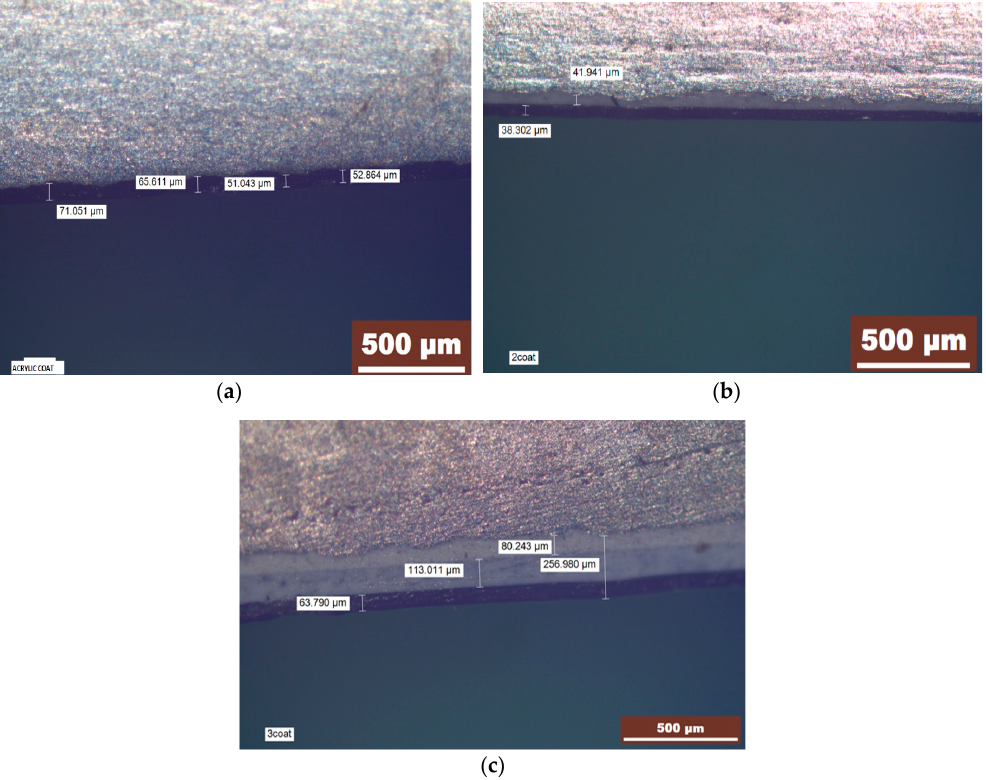
Figure 6. Microstructure images of the coating thickness: ( a ) Acrylic paint ED coat; ( b ) 2-coat polyester without primer; ( c ) 3-coat polyester with epoxy primer.